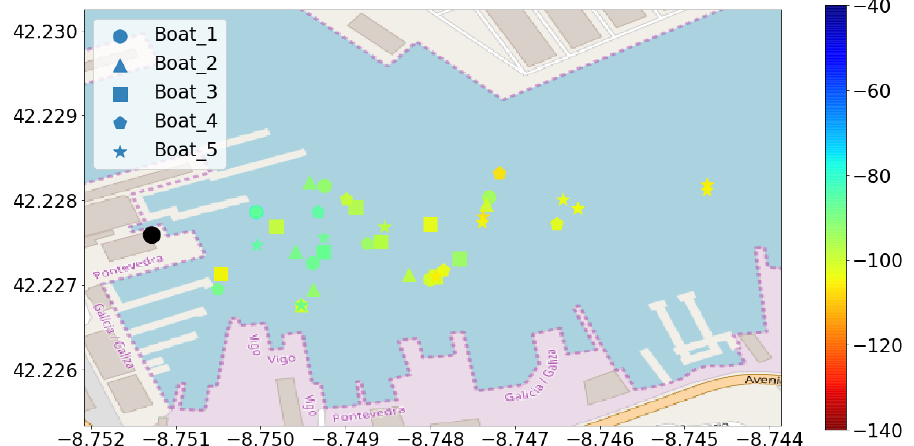
Figure 12. RSSI reception level (dBm) attained during the tracking of an Optimist training